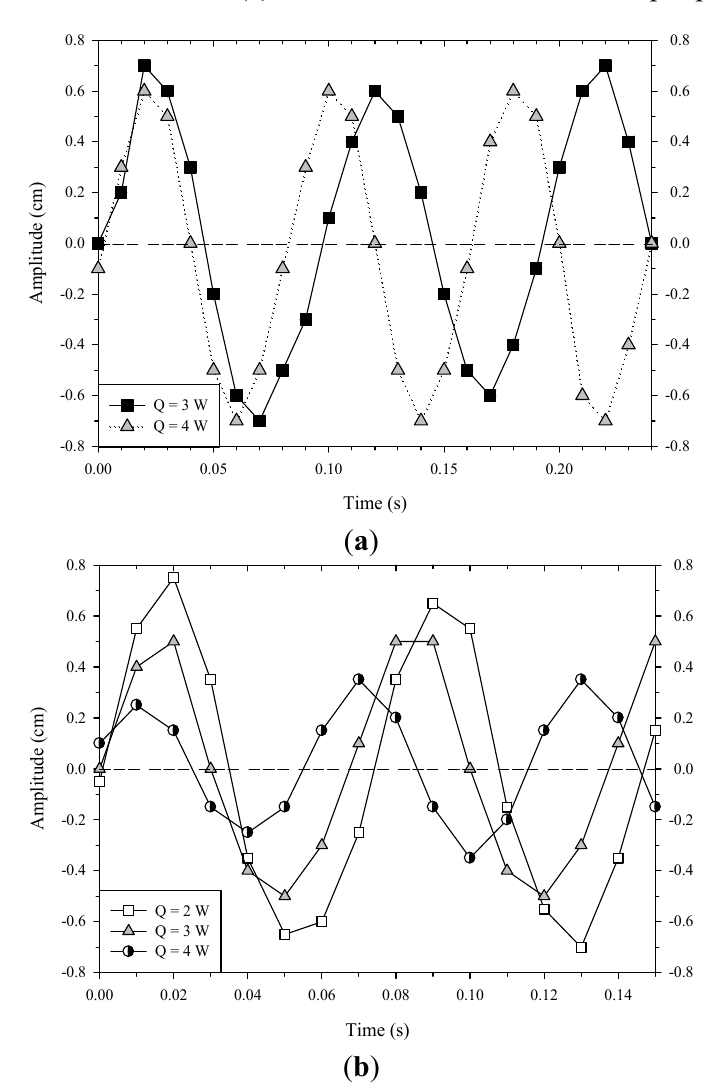
Figure 6. Time vs. displacement of a vapor slug in the vertical μ PHP containing ( a ) uniform channels and input powers of 3 to 4 W; ( b ) nonuniform channels and input powers of 2 W, 3 W, and 4 W; and ( c ) nonuniform channels and an input power of 6